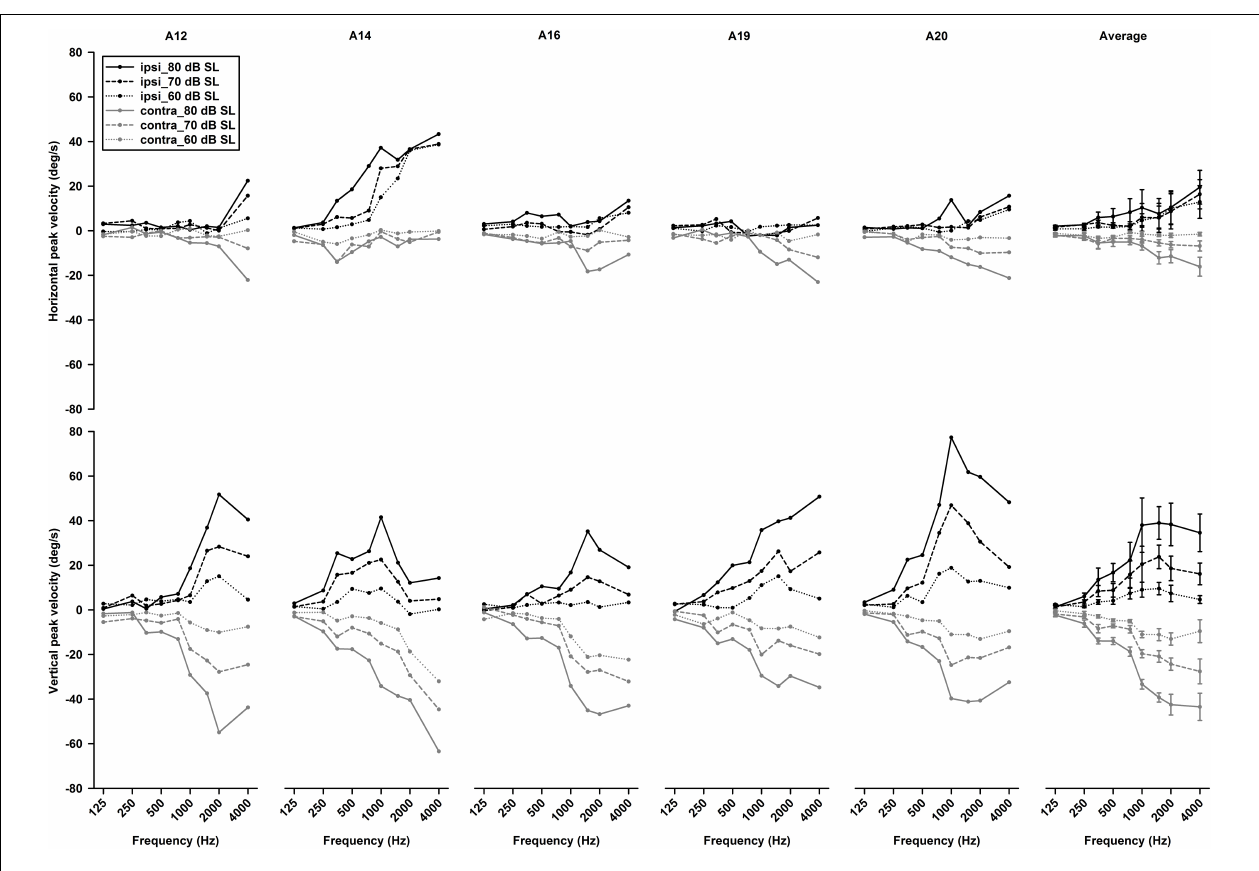
FIGURE 11 | Effects of intensity on tone bursts-evoked horizontal ( upper panels ) and vertical ( lower panels ) eye movements in five rats (the left five panels). The last right panels are the averaged tuning curves of the five